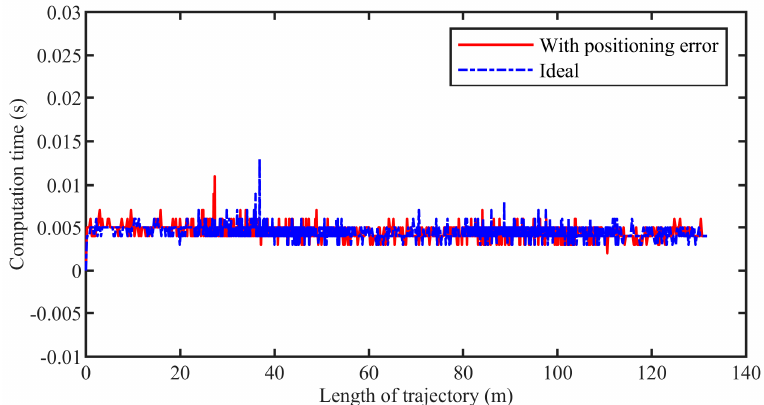
Figure 24. The computation time of the simulation with positioning errors.